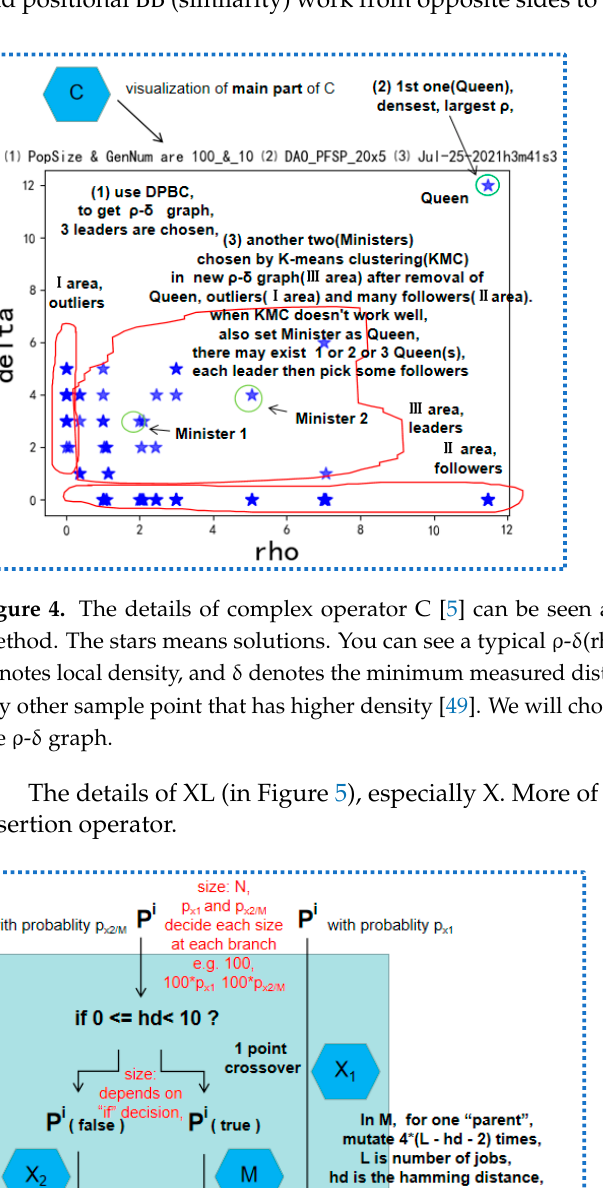
Figure 4. The details of complex operator C [5] can be seen above, which involves a clustering method. The stars means solutions. You can see a typical ρ - δ (rho-delta) graph in the simulation. ρ denotes local density, and δ denotes the minimum measured distance between one sample point and any other sample point that has higher density [49]. We will choose possible Queen and Ministers in the ρ - δ graph.